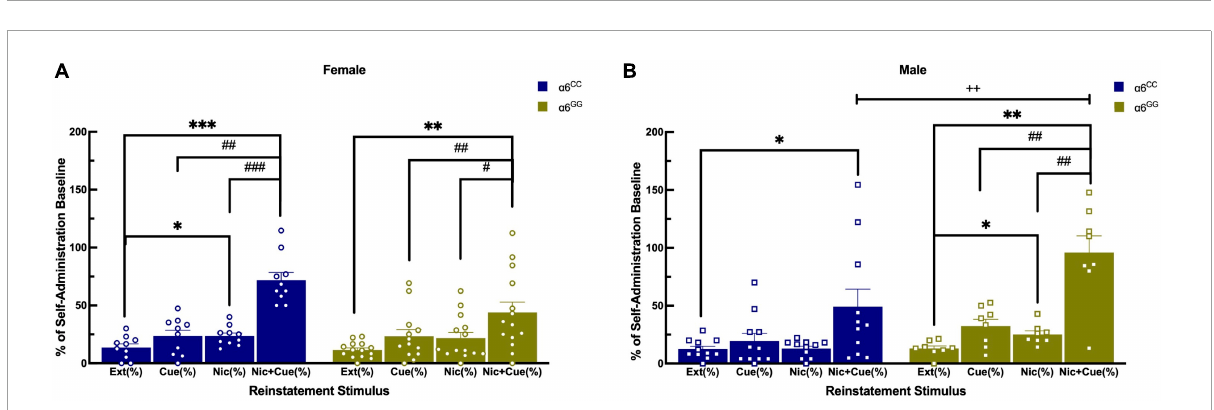
FIGURE5 Sex and genotype dependent effects of reinstatement of nicotine in humanized CHRNA 6 3 (cid:48) -UTR SNP rats. α 6 3 (cid:48) UTR SNP genotype- and sex-dependently influences nicotine + cue primed reinstatement, with males more impacted than females based on genotype (A,B) . ∗∗∗ p < 0.001, ∗∗ p < 0.01, ∗ p < 0.05 vs. Extinction; # p < 0.05, ## p < 0.01, ### p < 0.001 vs. Nicotine + Cue; ++ p = 0.01 Male α 6 GG compared with α 6 CC . N = 8–14/group. Circles represent females and squares represent